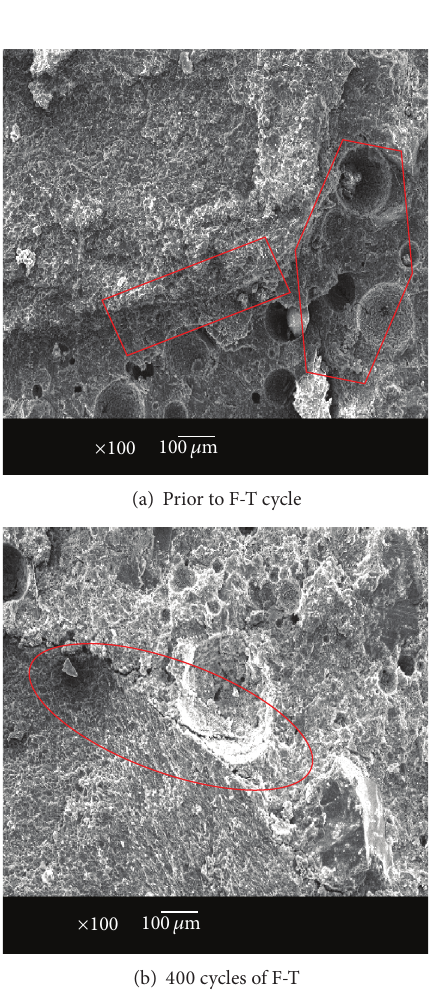
Figure 2: Scanning electron SEM microphoto graphs of A-E-C after F-T